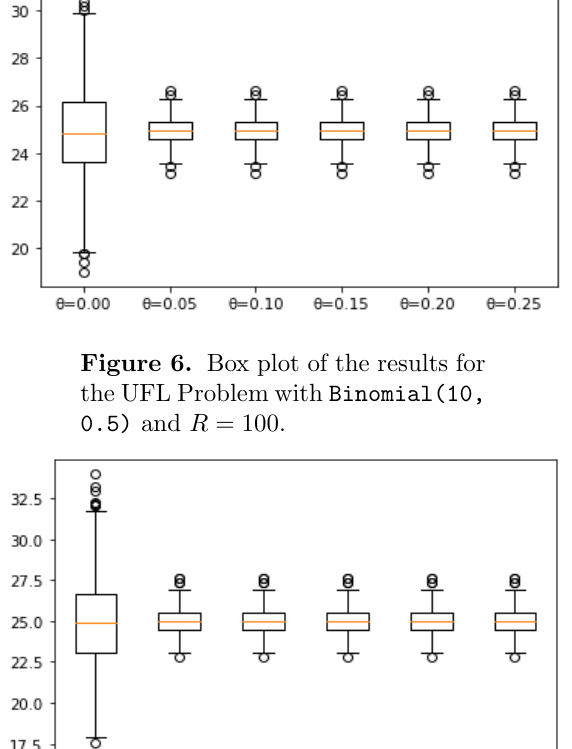
Figure 7. Box plot of the results for the UFL Problem with Poisson(5) and R =